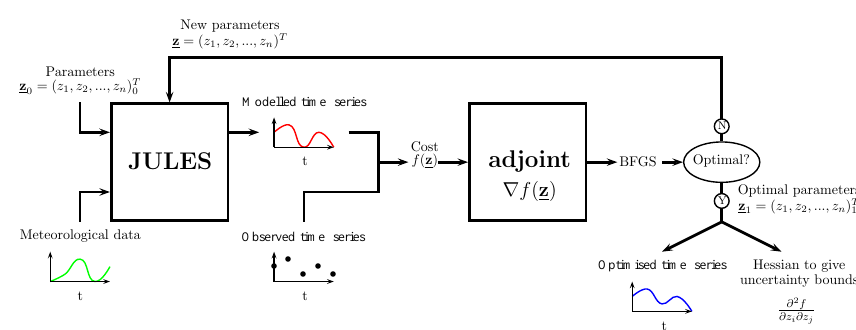
Figure 1. Schematic of the adJULES parameter estimation system starting with the initial parameter vector z 0 . This is usually based on default JULES parameter values (Blyth et al., 2010). The optimised parameter vector is denoted z 1